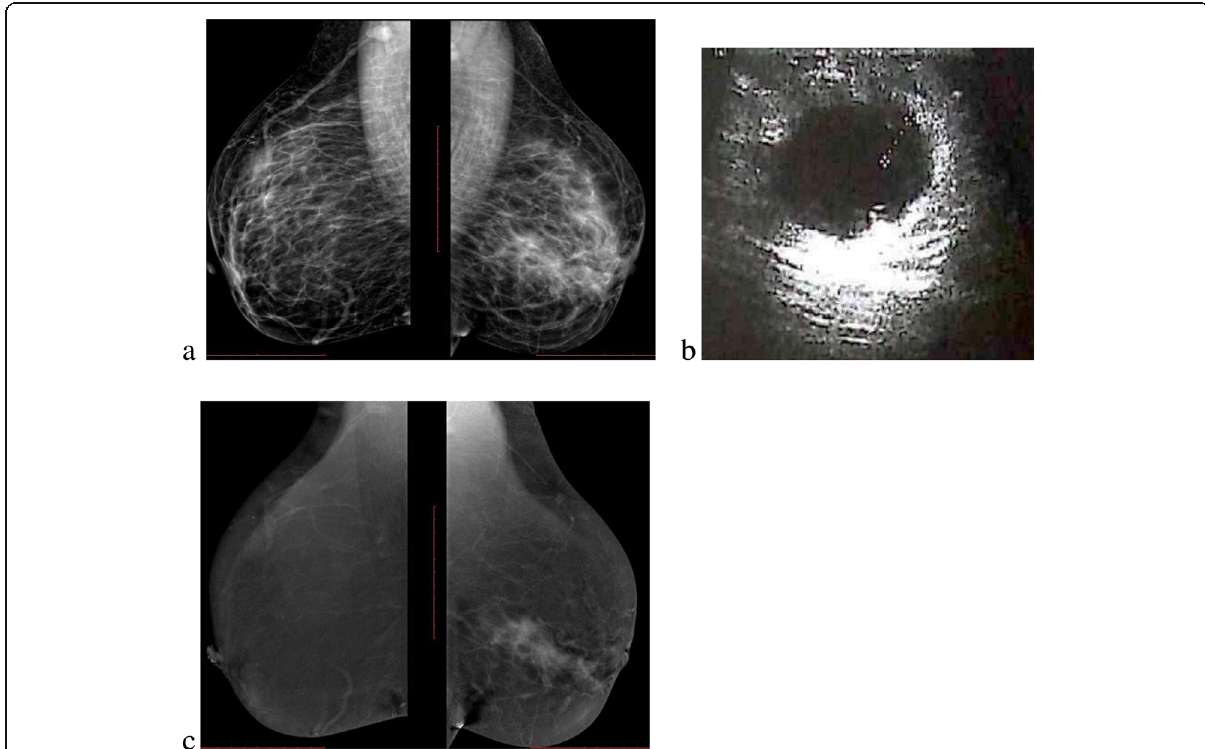
Fig. 5 A case of periductal mastitis with left focal asymmetry seen in digital mammography ( a ). b Ultrasound showed a focal area of increased echogenicity with a cystic lesion inside. c Recombined image of CEDM showing non-mass enhancement with associated rim